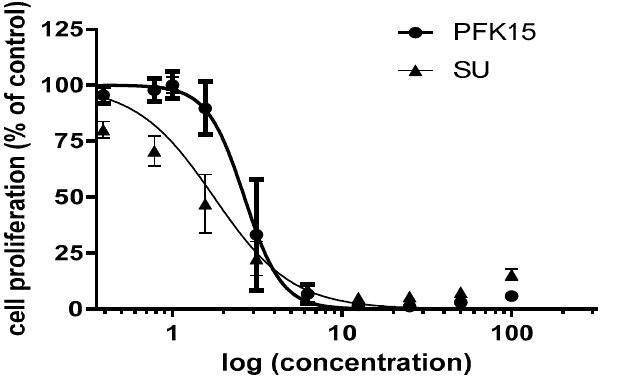
Figure 1. HUVEC response to PFK15 ((E)- 1-(pyridin-4-yl)-3-(quinolin-2-yl)prop-2-en-1-one) and sunitinib (SU) treatment after 72 h. Concentration values on the x-axis are on a logarithmic scale and are in µM.